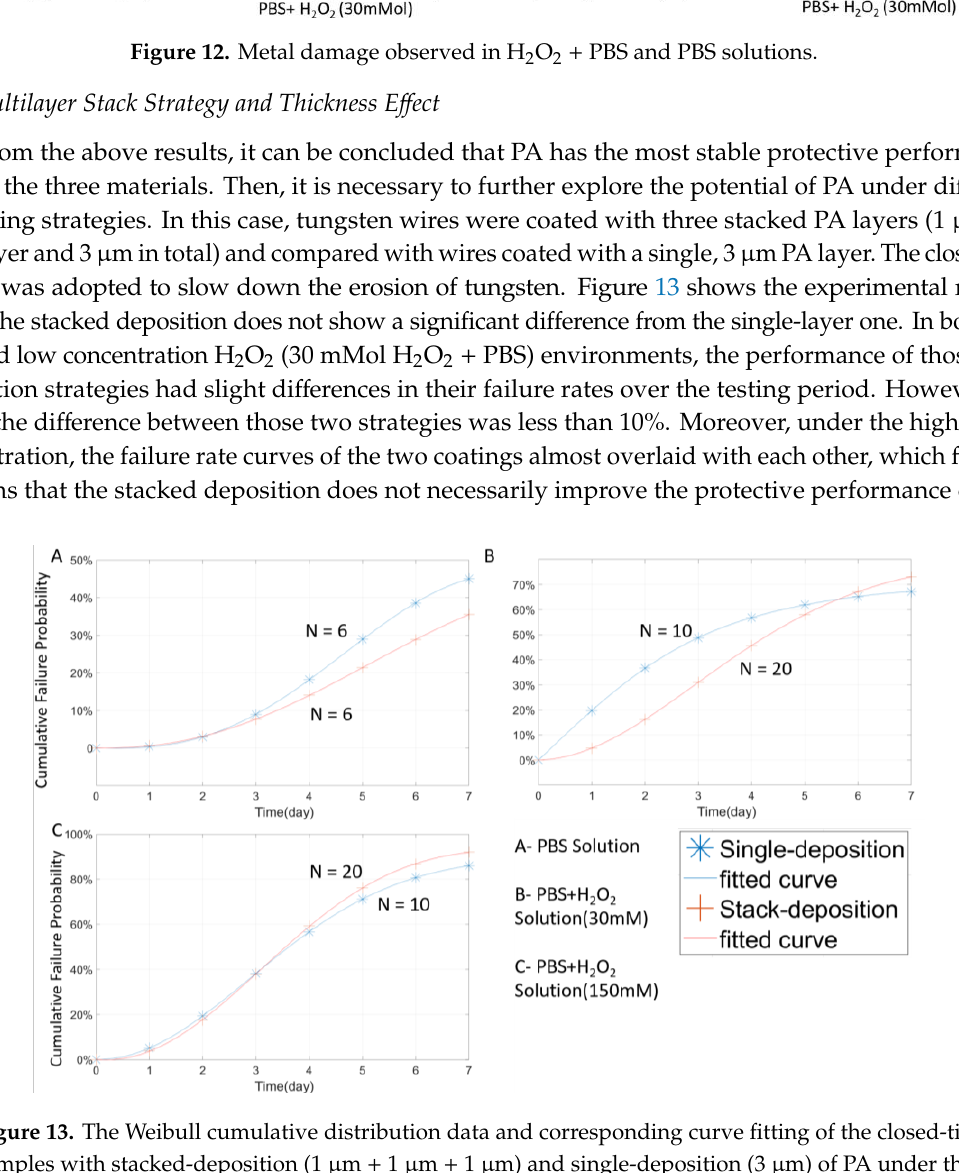
Figure 12. Metal damage observed in H 2 O 2 + PBS and PBS solutions.